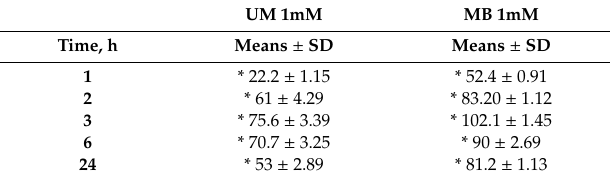
Table A2. UM and MB cell viability on PHM1-41 cells over